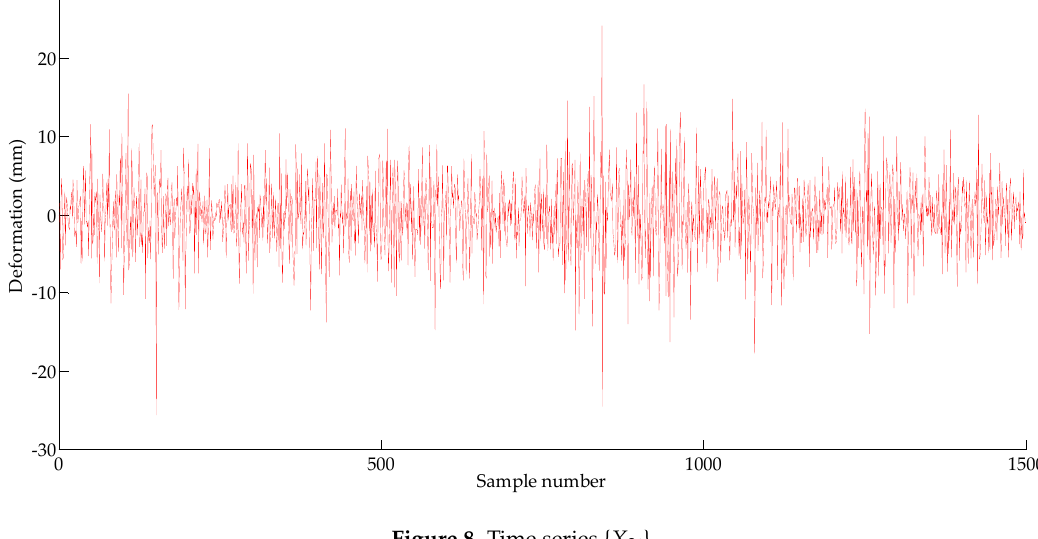
Figure 8. Time series {X 3t }.